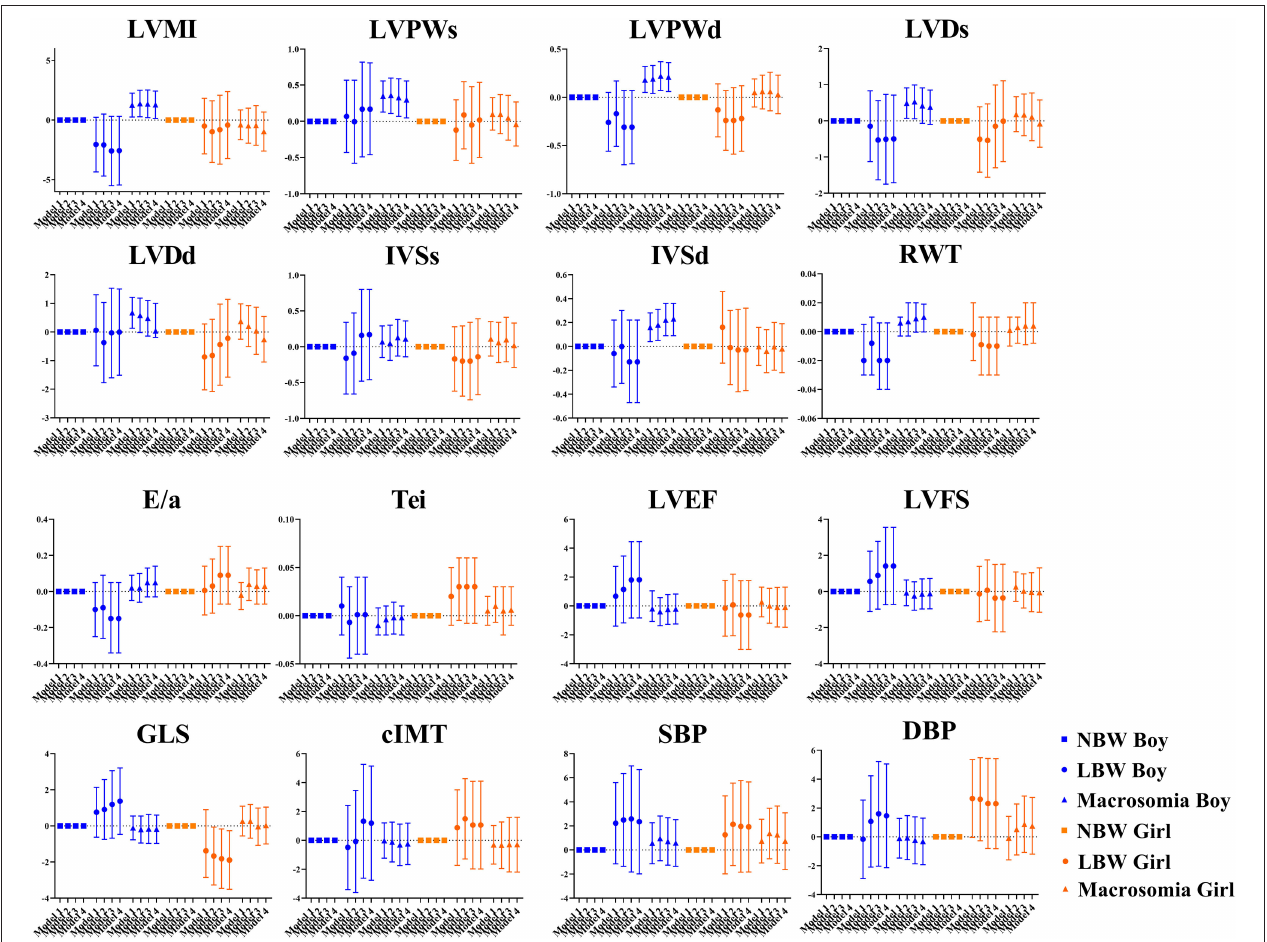
FIGURE 2 | Sex differences in the association between birthweight and cardiovascular parameters at the age of 4 years. Data was presented as mean difference with error bars displaying 95% confidence intervals for multivariable linear regression compared to participants with normal birthweight. Model 1: crude model; Model 2: adjusted for maternal factors including maternal age, ethnicity, educational level, alcohol intake (yes/no) and smoking status (yes/no) during pregnancy, gestational diabetes mellitus (yes/no), and hypertensive disorder during pregnancy (yes/no); Model 3: further adjusted for gestational age; Model 4: further adjusted for current